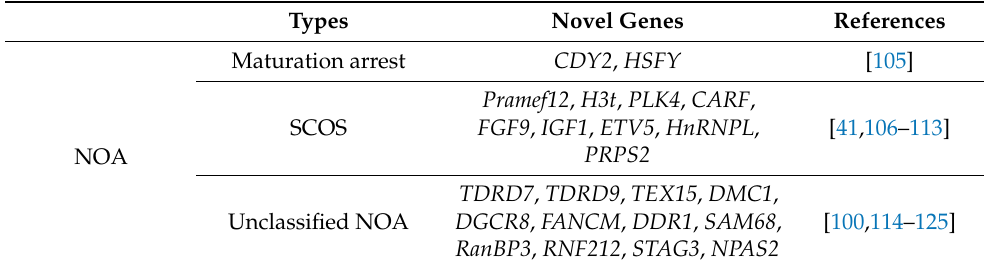
Table 2. Novel genes involved in abnormal human